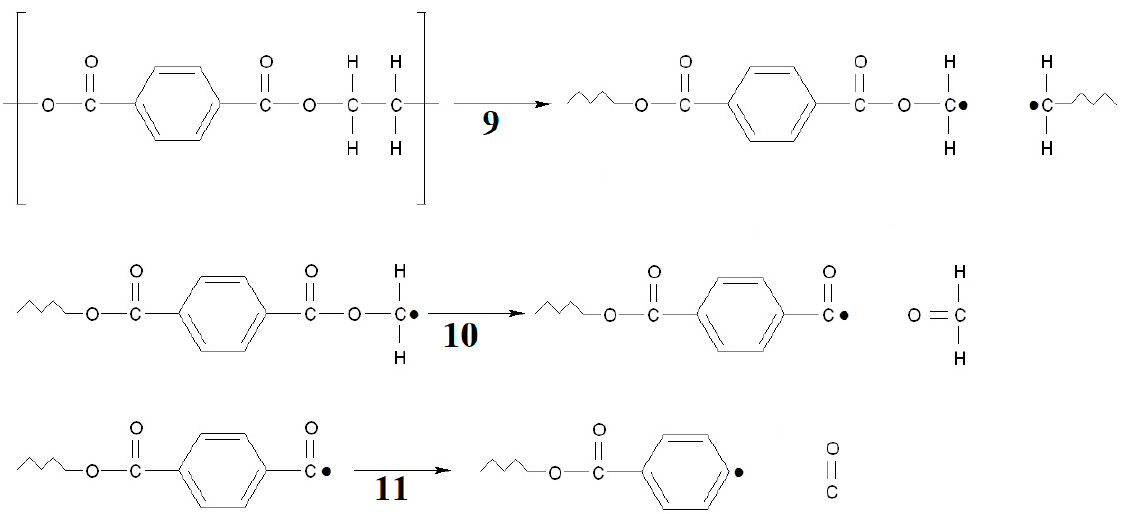
Figure 16. Schematic degeneration of PET by bond breaking at the ethylene element. The following symbols were applied: 9—cleavage of the C ‐ C bond in the ethylene group; 10—formation of a ben ‐ zoyl radical with a formaldehyde moiety; 11—cleavage of the benzoyl radical with formation of a phenyl radical.